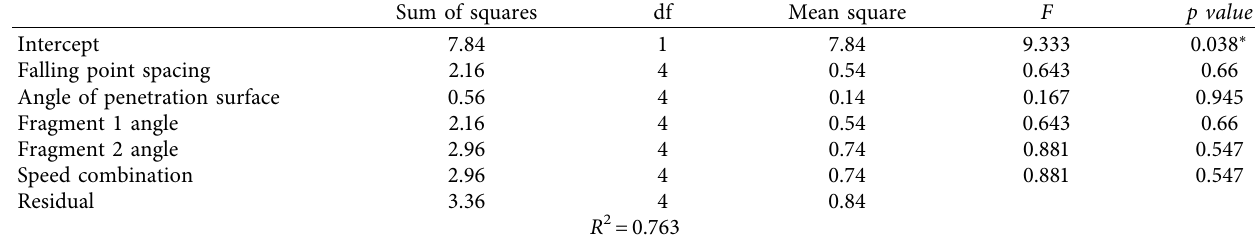
Table 12: Results of multifactor ANOVA of joint damage excluding the open pit area.